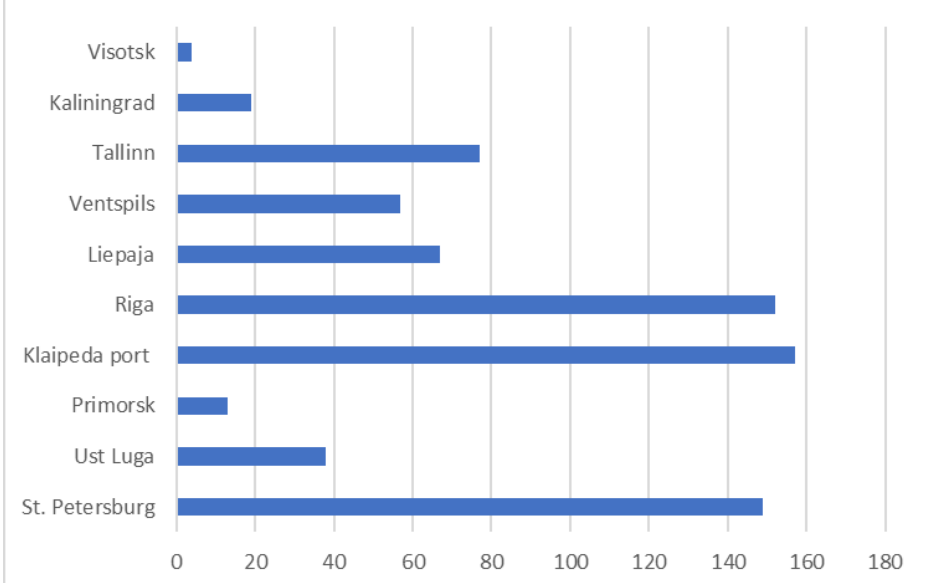
Logistics 2022 , 6 , x FOR PEER REVIEW Figure 15. Length of quays (kilometers). Figure 15. Length of quays (kilometers).